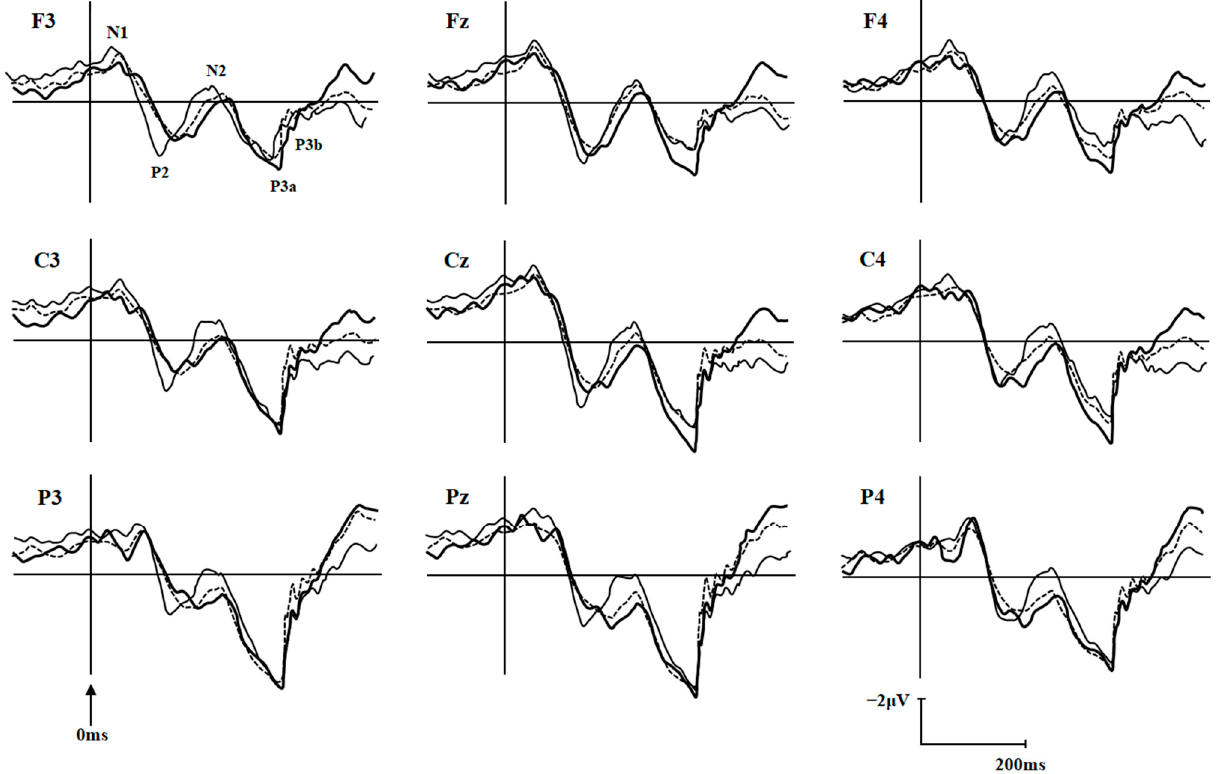
Figure 2. Grand averages of ERPs elicited by target under external emotional condition of Erotica at nine electrodes in the healthy volunteers (dashed line; n = 54), bipolar I disorder patients with (thick line; n = 27) and without (thin line; n = 26) hypersexuality.